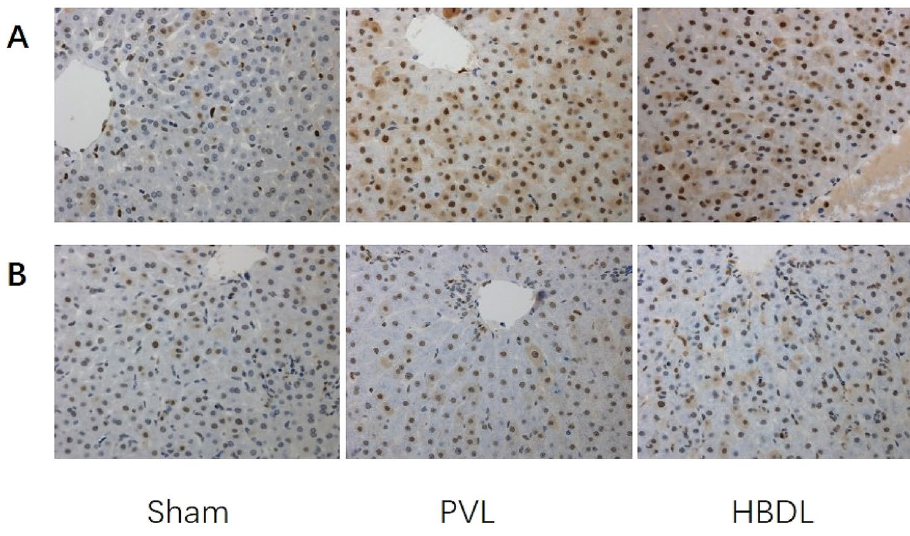
Figure 3. DNA synthesis in hepatocytes was assessed at different time points by immunohistochemical evaluation of PCNA incorporation into DNA. The first week after surgery ( A ); two weeks after surgery ( B ). (× 400).